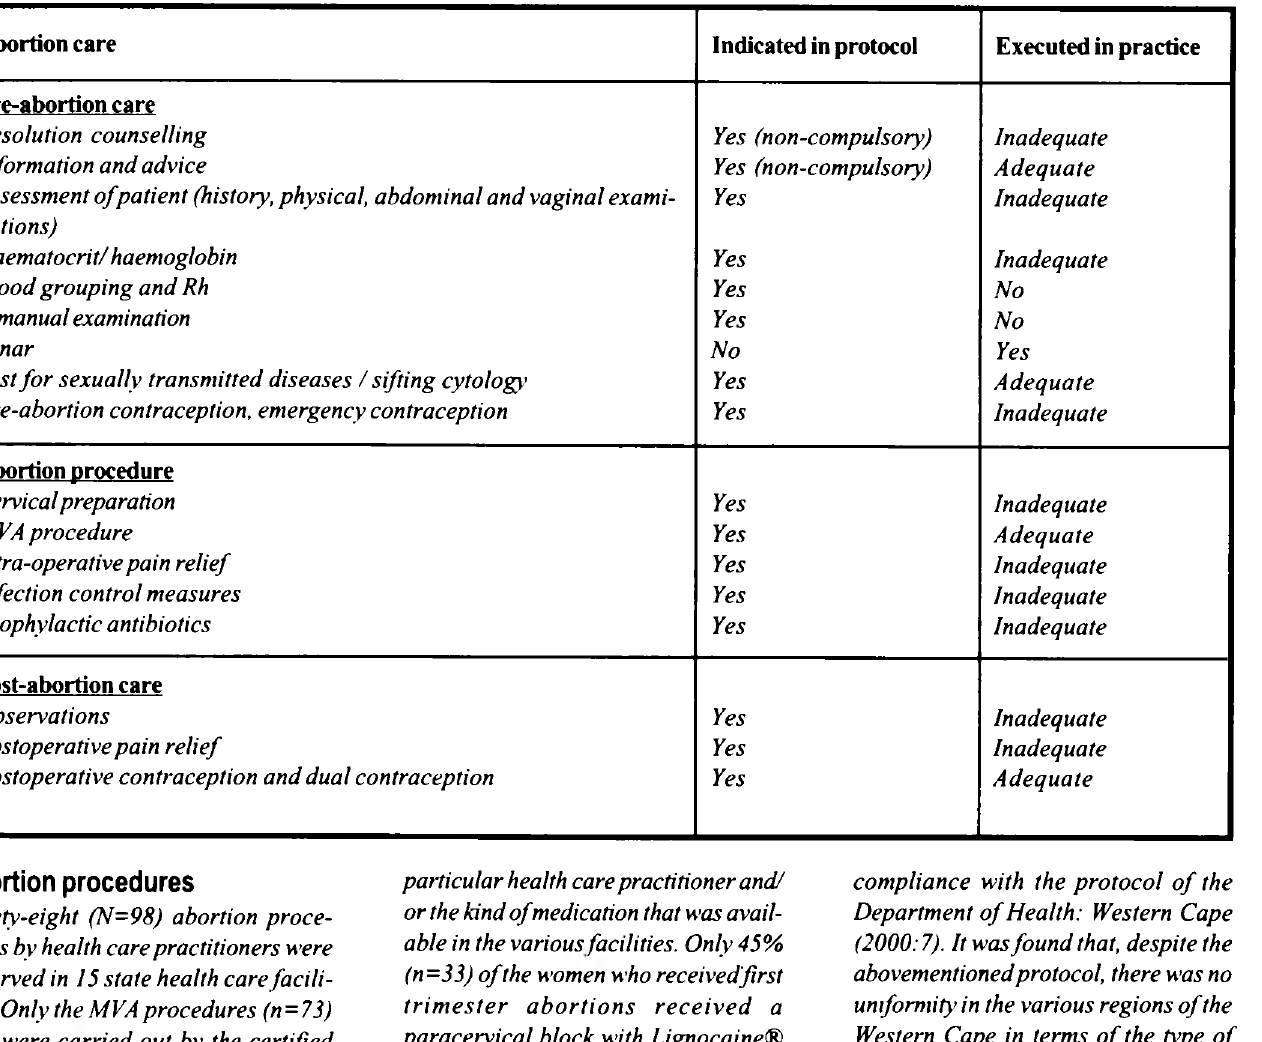
Table 1 - Abortion care skills of registered nurses Abortion care Indicated in